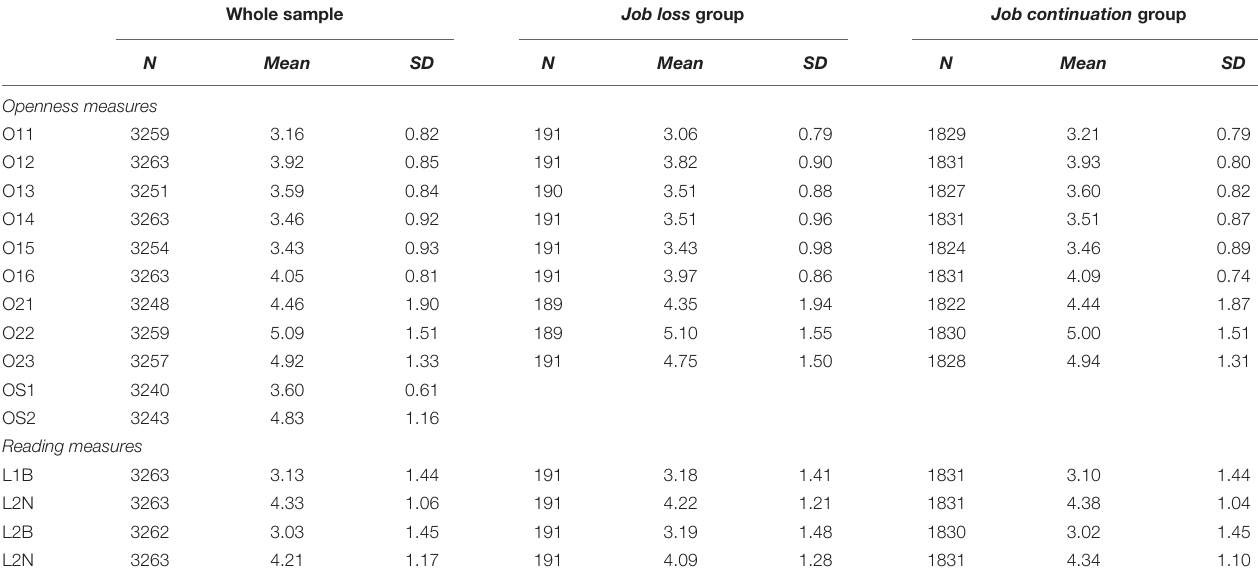
TABLE 2 | Descriptive statistics in the general sample, the job loss group, and the job continuation group. Whole sample Job loss group